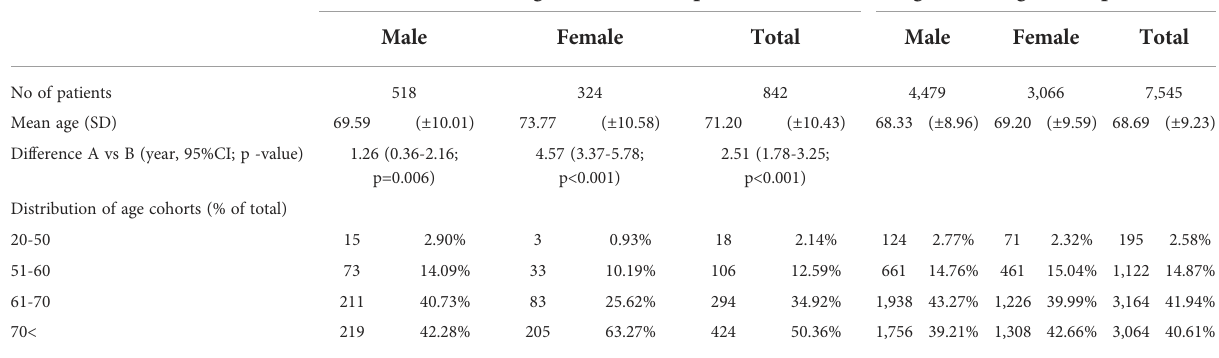
TABLE 1 Patient characteristics of the study population.